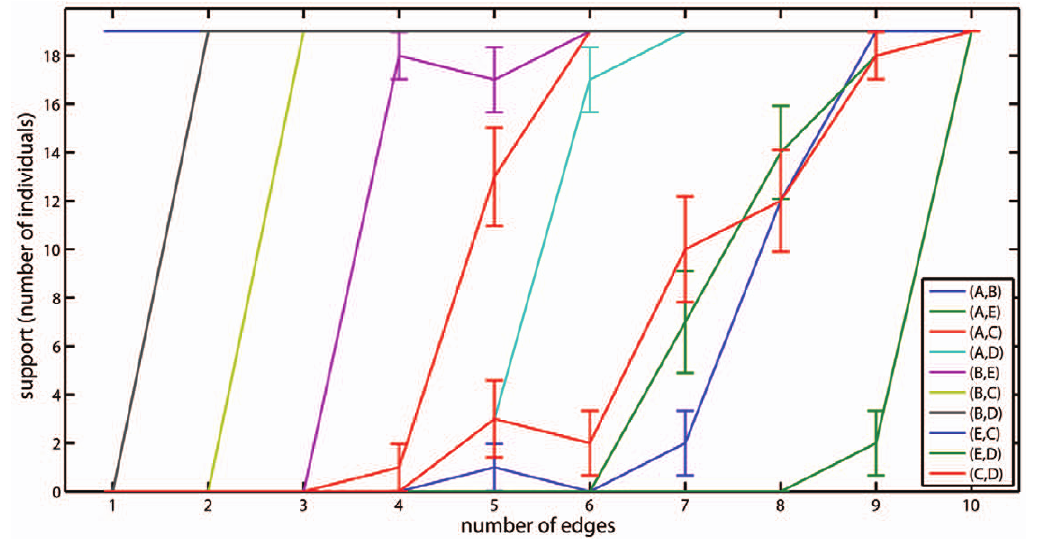
Figure 5. Level of support of each edge in all individual best-fitting models with fixed number of edges. The results are for BIC scores in